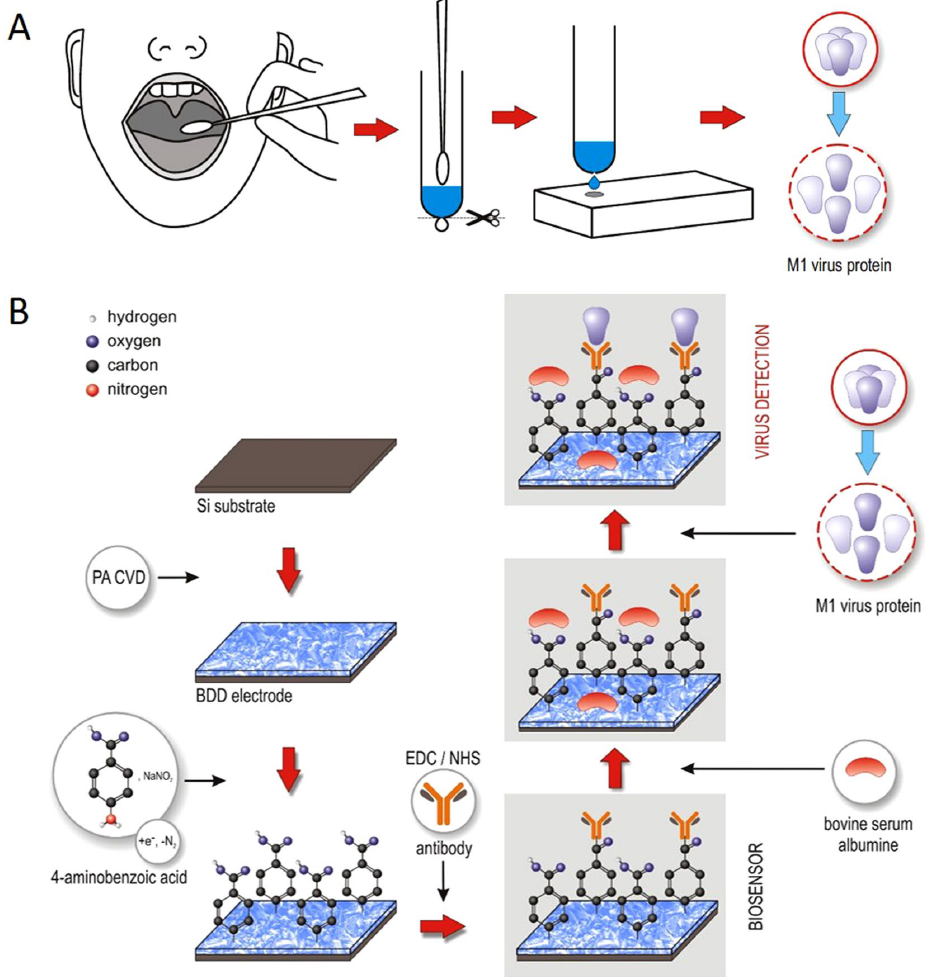
Figure 1. Schematic illustration of biosensing system. ( A ) Throat swab culture acquisition. ( B ) Boron-doped Figure 18. ( A ) Throat swab culture acquisition. ( B ) Boron-doped diamond electrode surface mod- diamond electrode surface modification with polyclonal anti-M1 antibodies, which then serve to identify the ification with polyclonal anti-M1 antibodies. The electrode identifies the universal biomarker for universal biomarker for influenza virus, the M1 protein. influenza virus, the M1 protein